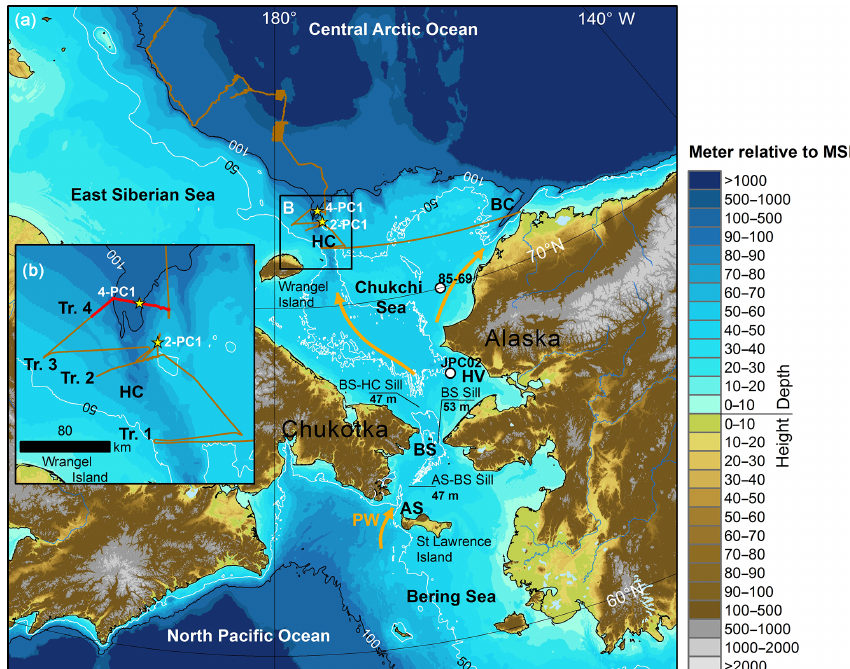
Figure 1. (a) Overview map of the western Arctic Ocean and the northern Pacific Ocean connected by the ∼ 53m deep Bering Strait (BS). The study area of Herald Canyon (HC) is shown in detail in the inset map (b) . The main route for the present Pacific water (PW) inflow into the Arctic Ocean through the BS is shown with orange arrows. There are two bathymetric sills slightly shallower ( ∼ 47m deep) than the BS, the BS-HC sill and the Anadyr Strait (AS)-BS sill. The locations of SWERUS-C3 cores 4-PC1 and 2-PC1, the focus of this study, are shown with yellow stars. Key cores from previous studies referred to in this work regarding the reopening of the BS after the LGM are shown with white dots (85–69, Elias et al., 1992, 1996; JPC 02, Keigwin et al., 2006). The bathymetry is from the Alaska Region Digital Elevation Model (ARDEM; Danielson et al., 2015). The leg 2 cruise track of the SWERUS-C3 expedition in 2014 is shown with a brown line. HV = Hope Valley. Tr. 1, 2, 3 and 4 indicate the transects across Herald Canyon referred to in the text. Figure 4 shows transects 3 and 4, and Fig. 5 shows transect